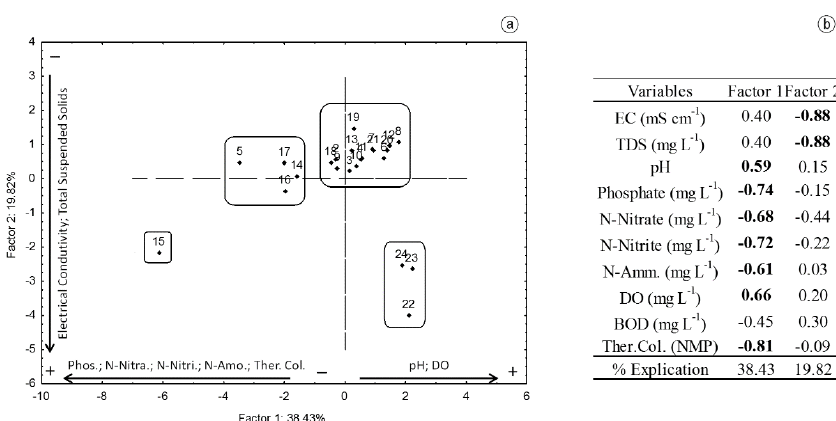
Figure 5. Principal Components Analysis of the sampling points of the Apodi/Mossoró river hydrographic basin, in the month of February of 2008. a) Representation of the two first PCA components; b) Variables correlation values. EC: Electric Conductivity; TDS: Total dissolved solids; N-Amm.: Ammoniacal nitrogen; DO: Dissolved oxygen; BOD: Biochemical Oxygen Demand; Ther. Col.: Thermotolerant